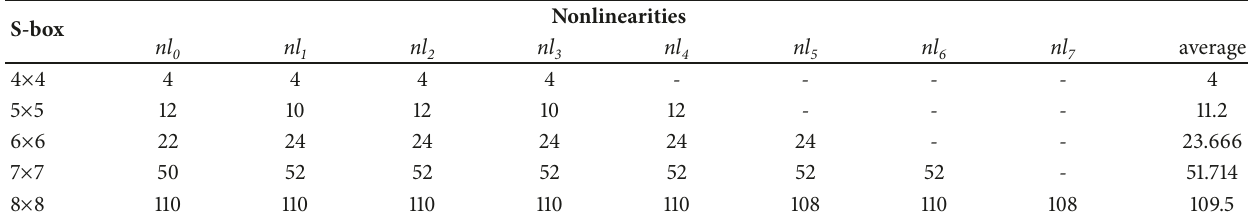
Table 9: Nonlinearities of n Boolean functions f